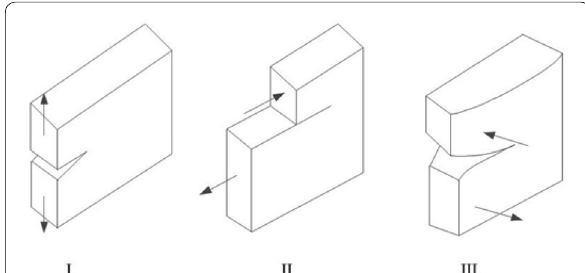
Figure 12 “Open” (I), “sliding” (II), and “tear” (III) types of cracks